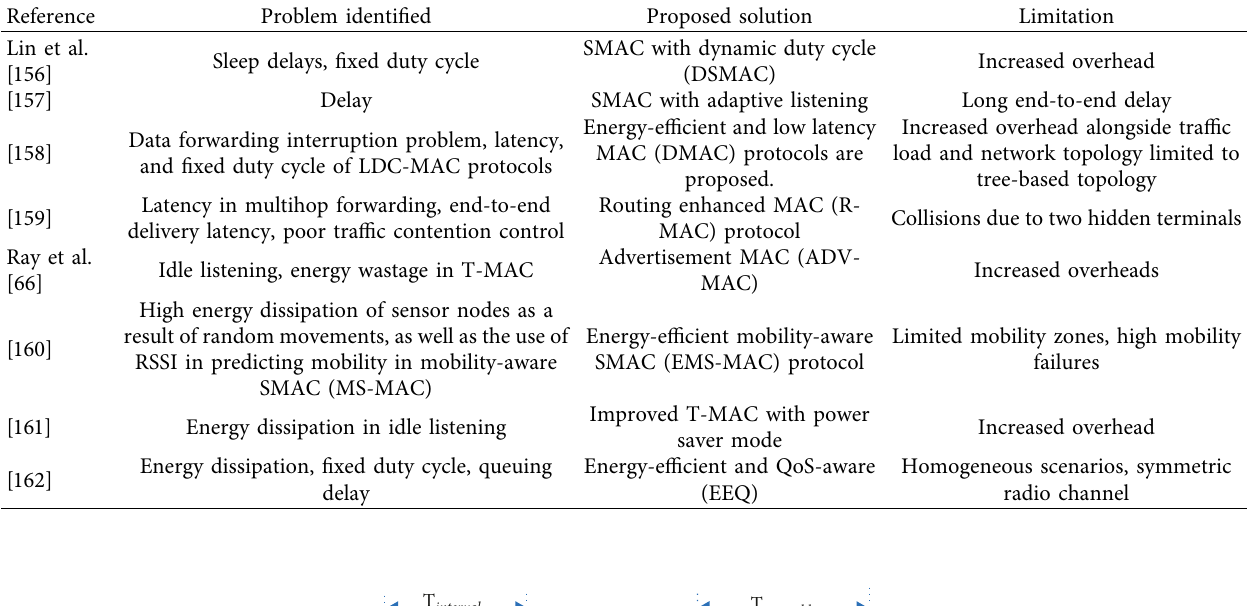
Table 2: Comparative study of SLDC MAC